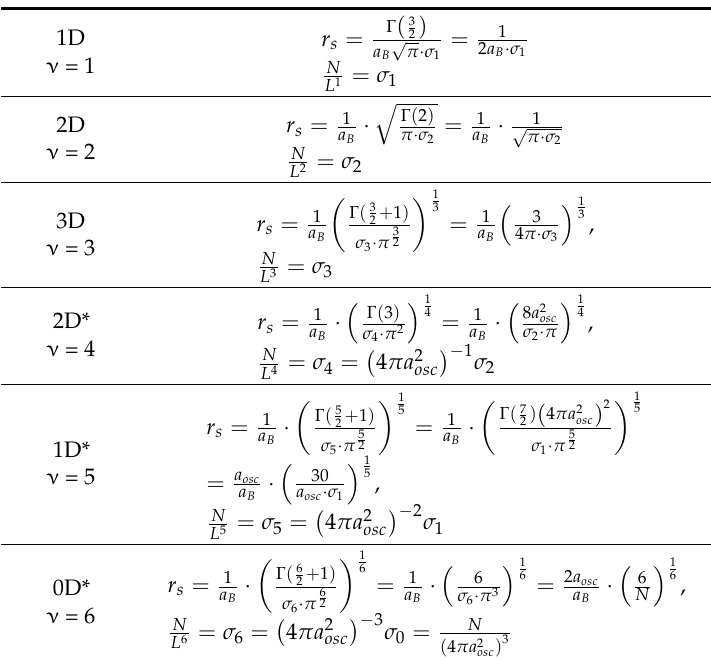
Table 2. Dimensionless universal